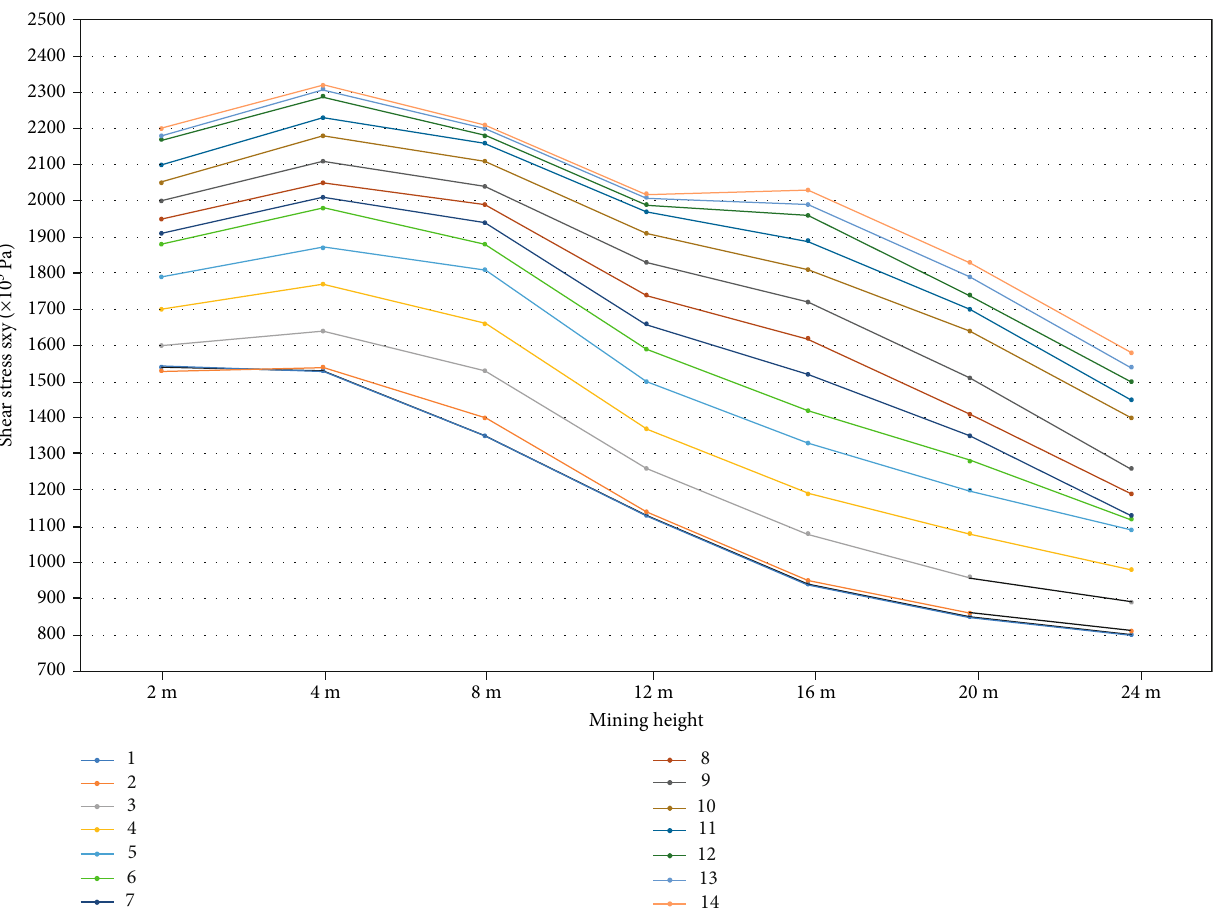
Figure 8: Variation of shear stress with mining heights in the monitoring area (1 ~